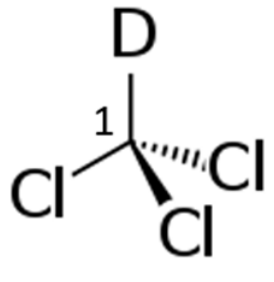
Figure 9. CDCl 3 carbon atom detectable by T1 13 C NMR. Figure 9. CDCl carbon atom detectable by T1 13 C NMR. Table 8. Octanal in CDCl 3 : T1 bulk and T1 ads resulting from analysis of the inversion recovery curves 3 (Figures S7–S9) from 13 C NMR spectra in high-field (600 MHz). * the value of 0.64 is very different from the ratio, possibly due to an overlap with impurities in the